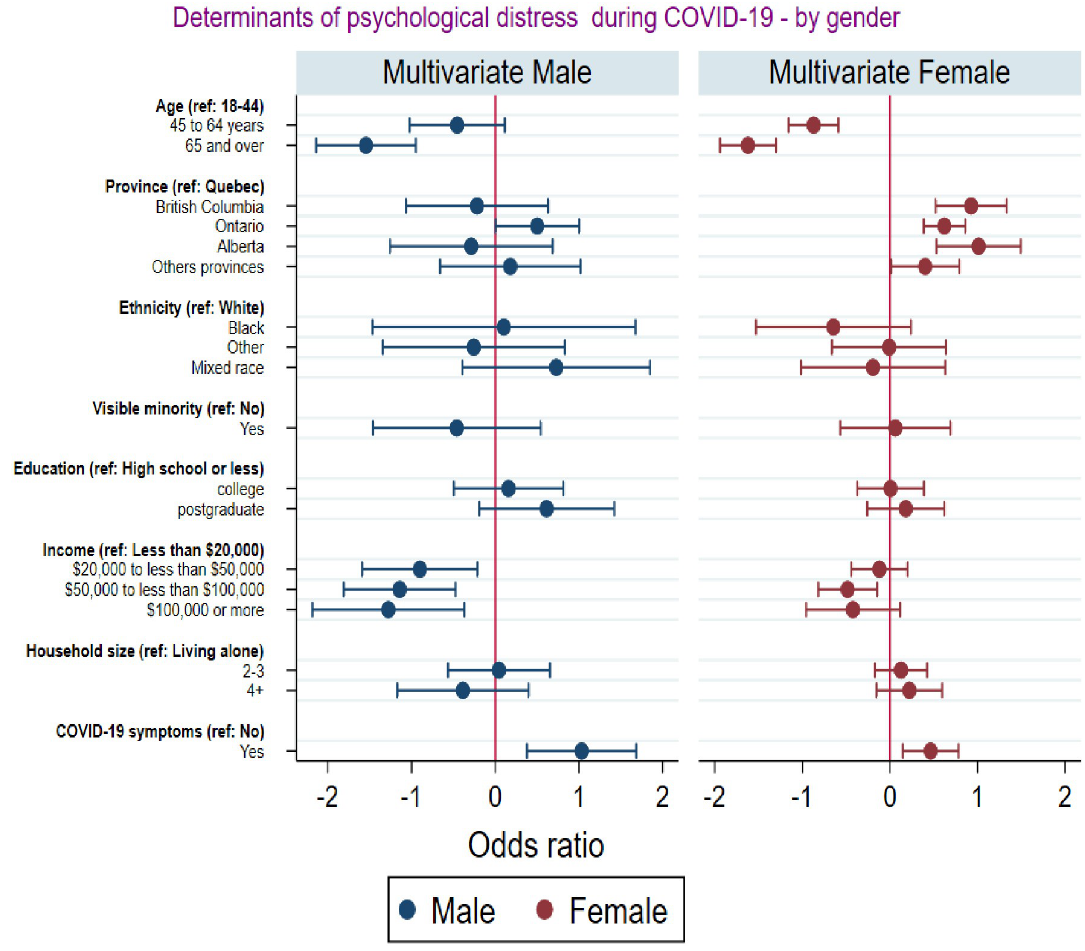
Fig 4. Multinomial logit results on the predictors of psychological distress by